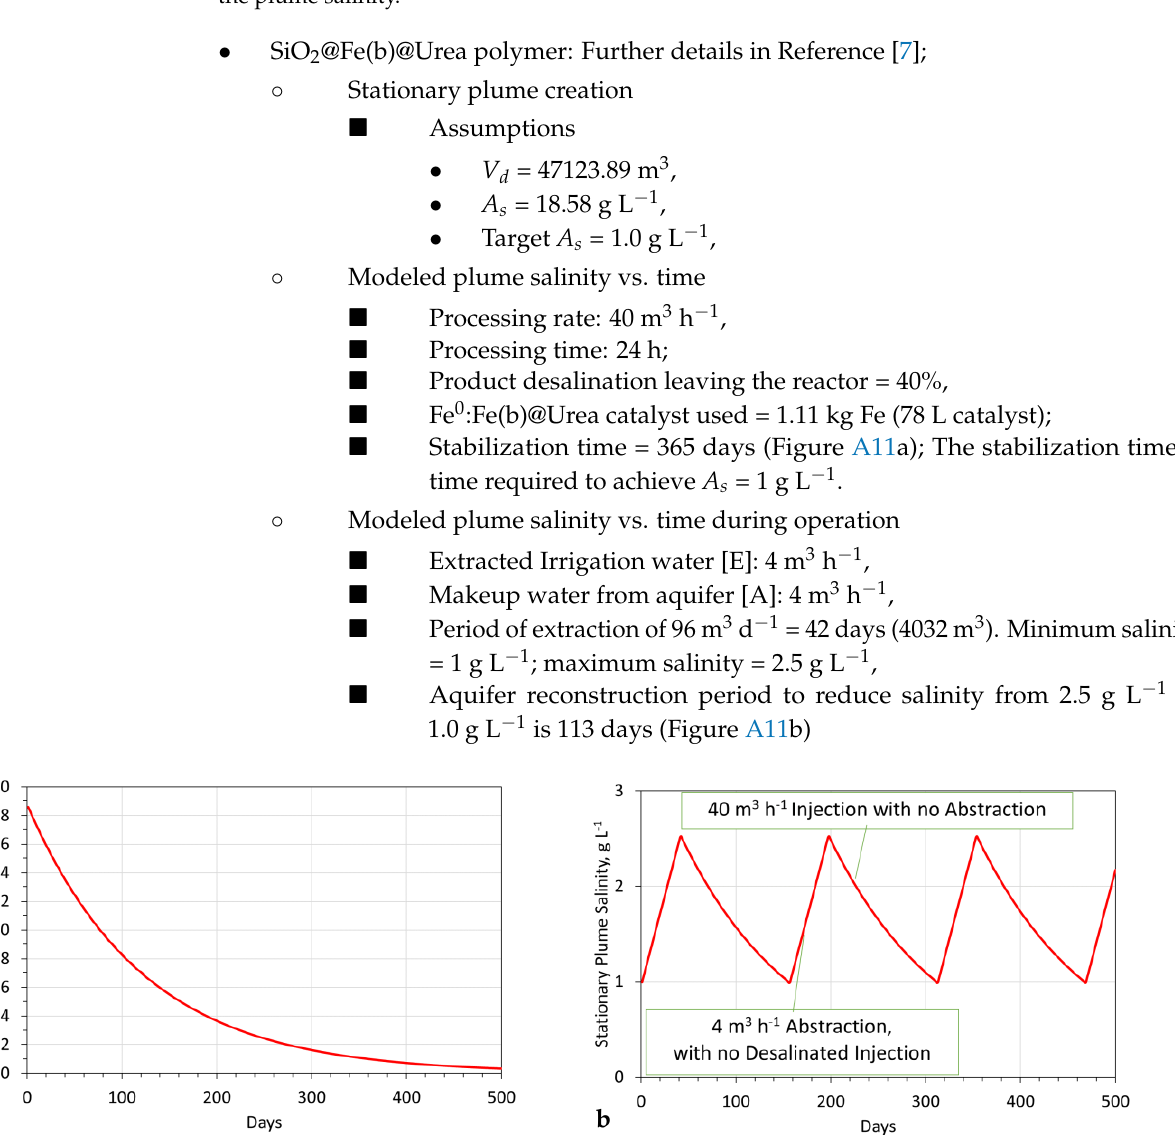
Figure A11. Modeled stationary plume. SiO 2 @Fe(b)@Urea polymer catalyst: ( a ) time required to reduce the plume salinity. ( b ) Salinity of irrigation water versus time, and aquifer recharge